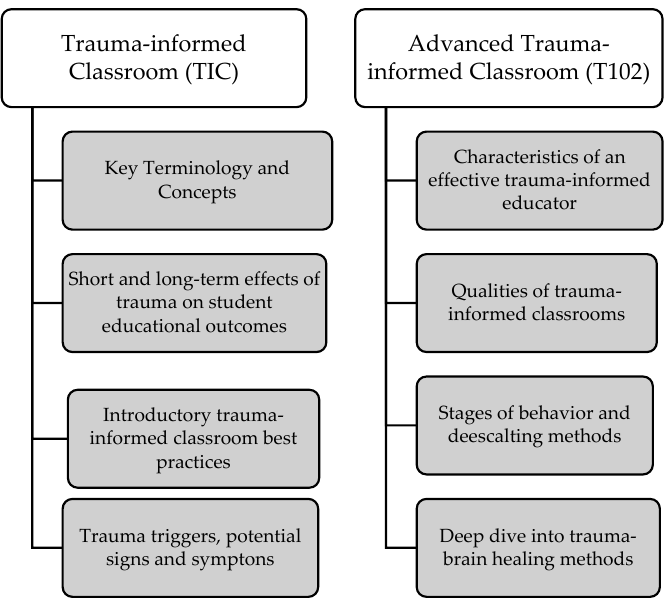
Figure 1. TIC and T102 training components.